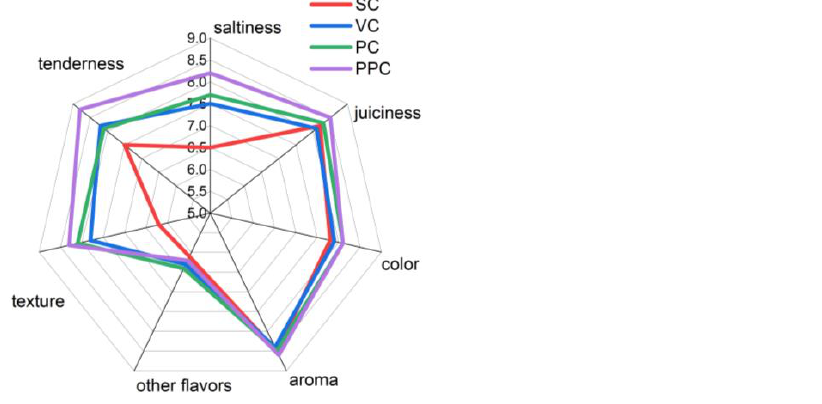
Figure 3. Effect of beef with different curing treatments on the sensory attributes as evaluated by a trained panel. (SC = static curing, VC = vacuum curing, PC = pressurized curing, PPC = pulsed pressure curing). Table 2. Consumer acceptability tests of beef with different curing treatments by a cohort of adult consumers using a 9-point hedonic scale from 1 = dislike extremely to 9 = like extremely.